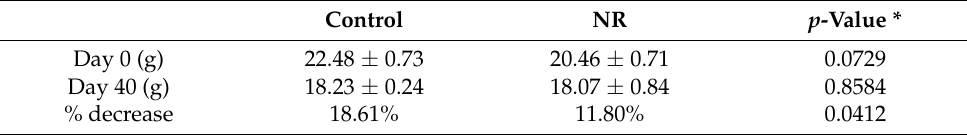
Table 1. The body weight of the mice and the percentage of weight loss during the